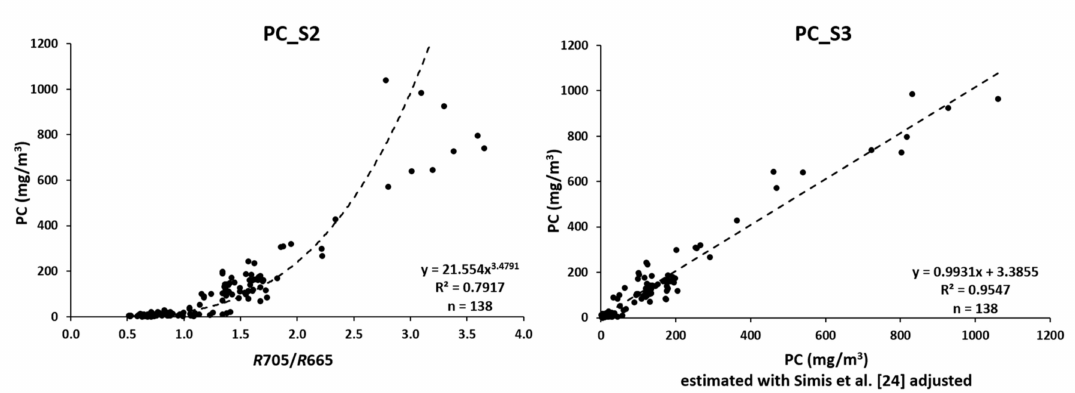
Figure 10. PC algorithms recalculated using all